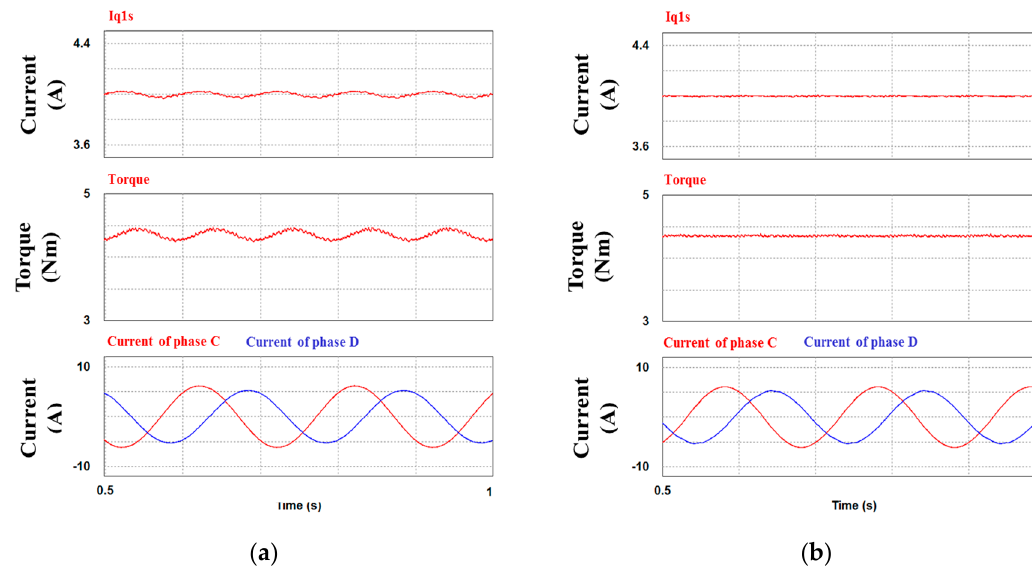
Figure 11. Simulation result of fault ‐ tolerant control under open fault phases B in i q1s = 4 A and 300 rpm: ( a ) Without tolerant control; ( b ) With tolerant control.